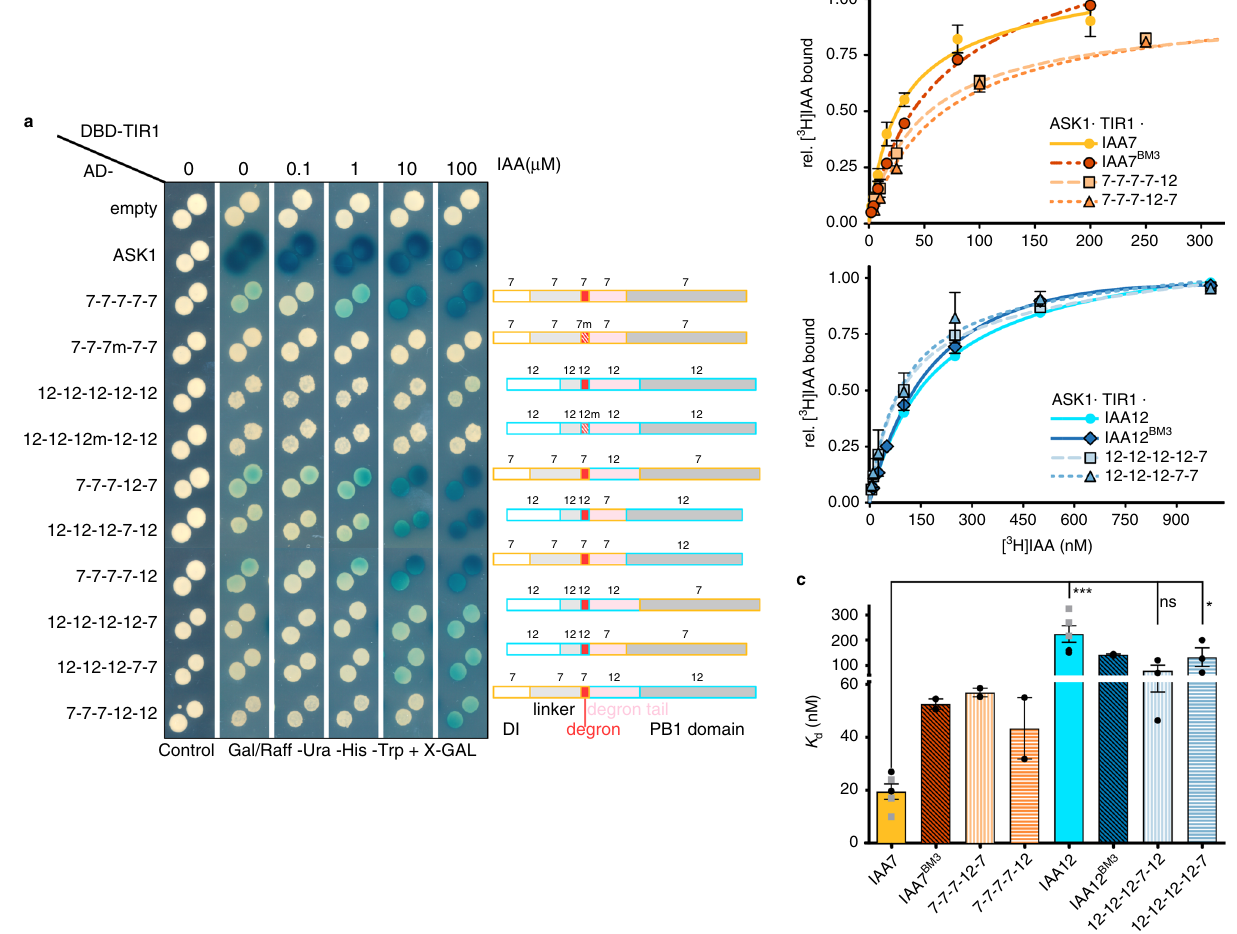
Fig. 2 Auxin-dependent TIR1·IAA7 and TIR1·IAA12 interactions rely on the interplay between the degron, degron tail and the PB1 domain. a Y2H interaction matrix (left) for TIR1 with ASK1, and ten chimeric proteins built by fusing IAA7 and IAA12 segments fl anked by conserved motifs throughout the AUX/IAA family. Yeast diploids containing LexA DBD-TIR1 and AD-AUX/IAA chimeras were spotted to selective medium with increasing IAA concentrations, and β -galactosidase reporter expression indicated TIR1·AUX/IAA interactions. AD-empty vector as negative control. Domain organization and composition of seamless chimeric IAA7 (orange) and IAA12 (aquamarine) constructs depicted in boxes (right) with DI (white) (till KR motif), linker (light gray), core degron (red), degron tail (light pink), and PB1 domain (dark gray). b Saturation binding assays using [ 3 H]IAA and recombinant ASK1·TIR1·IAA7 (shades of orange) or ASK1·TIR1·IAA12 (shades of blue) ternary complexes. TIR1·IAA7 complex exhibits a high af fi nity ( K d = ~20 nM) for auxin, whereas IAA12-containing co-receptor complexes provide tenfold lower af fi nity for auxin ( K d = ~200 nM). Oligomerization-de fi cient IAA7 BM3 and IAA12 BM3 variants, and chimeric AUX/IAA proteins in complex with ASK1·TIR1 distinctly affect auxin bind capabilities of a co-receptor system. Shown are saturation binding curves for each co-receptor pair as relative [ 3 H]IAA binding normalized to the highest value of each curve. Each point re fl ects means of 2 – 3 independent experiments ( n = 3 for 12-12-12-7-12 and 12-12-12-12-7; otherwise n = 2), each of them comprising of technical triplicates, and depicted as means ± SEM. c Comparison of dissociation constants ( K d ) obtained in saturation-binding experiments for each ASK1·TIR1·AUX/IAA ternary complex. Shown are mean values from our experiments (black dots) combined with published 24 K d values for IAA7 and IAA12 (gray squares) K d values depicted as means ± SEM ( n = 2 + 3 for IAA7 and IAA12; n = 3 for 12-12-12-7-12 and 12-12-12-12-7: otherwise n = 2). For n ≥ 3, signi fi cant differences are indicated (Dunnett ’ s multiple comparison test, IAA7 as reference; * p < 0.0322, *** p <